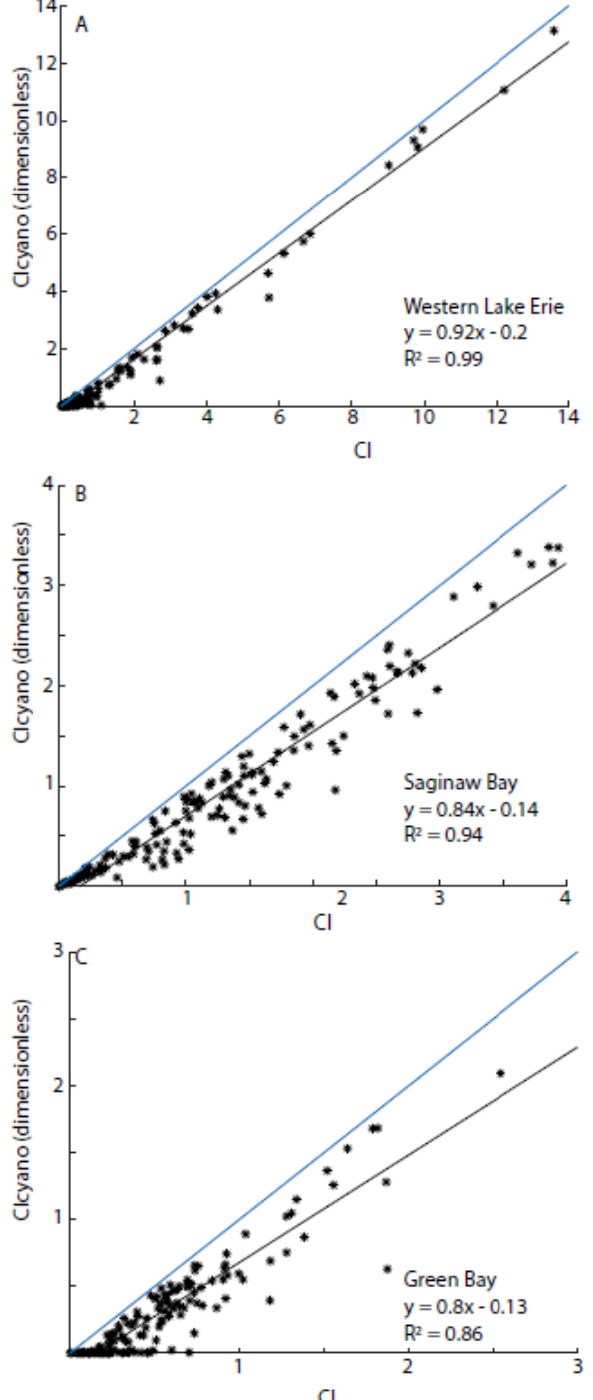
Figure 2. Linear regression analysis between the CI and the CI cyano algorithms for each basin. The relationship between the dimensionless CI and CI cyano for western Lake Erie ( A ), Saginaw Bay ( B ), and Green Bay ( C ) are shown from 10-day composites obtained from June through October from the MERIS timeseries. Points indicate individual 10-day composite match-ups for each algorithm, the black line indicates the linear regression, and the blue line denotes a hypothetical line of 1 indicative of no difference between algorithms. The relatively high frequencies of zero points along the x -axis indicates that there are a number of non-zero values in the CI that were zero in the CI cyano